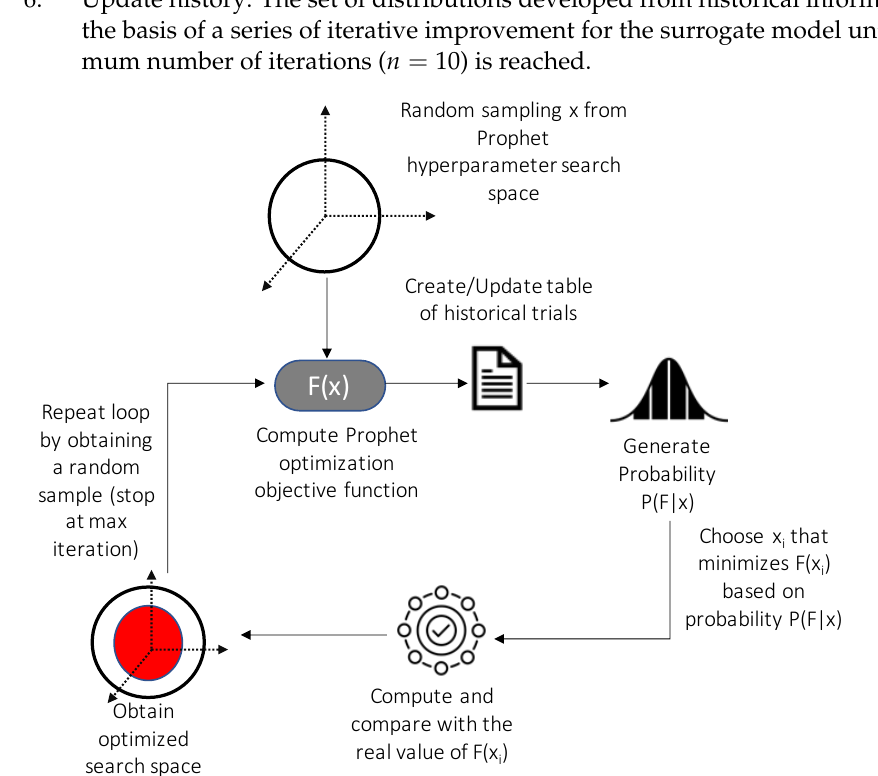
Figure 3. Optimization methodology of the Bayesian True Parzen Estimator with the Prophet-based objective function (Prophet-TPE).